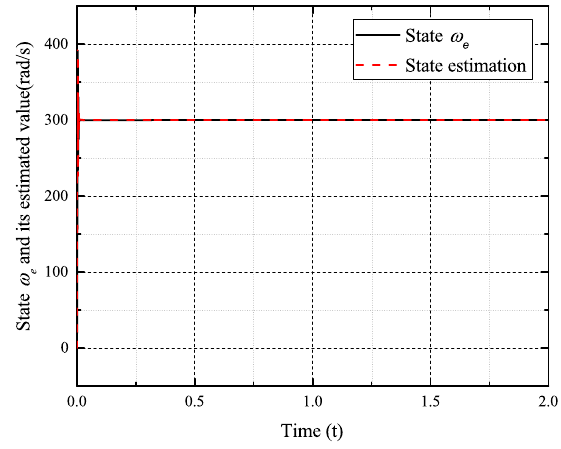
Figure 16. State ω e and its estimated value ˆ ω e .